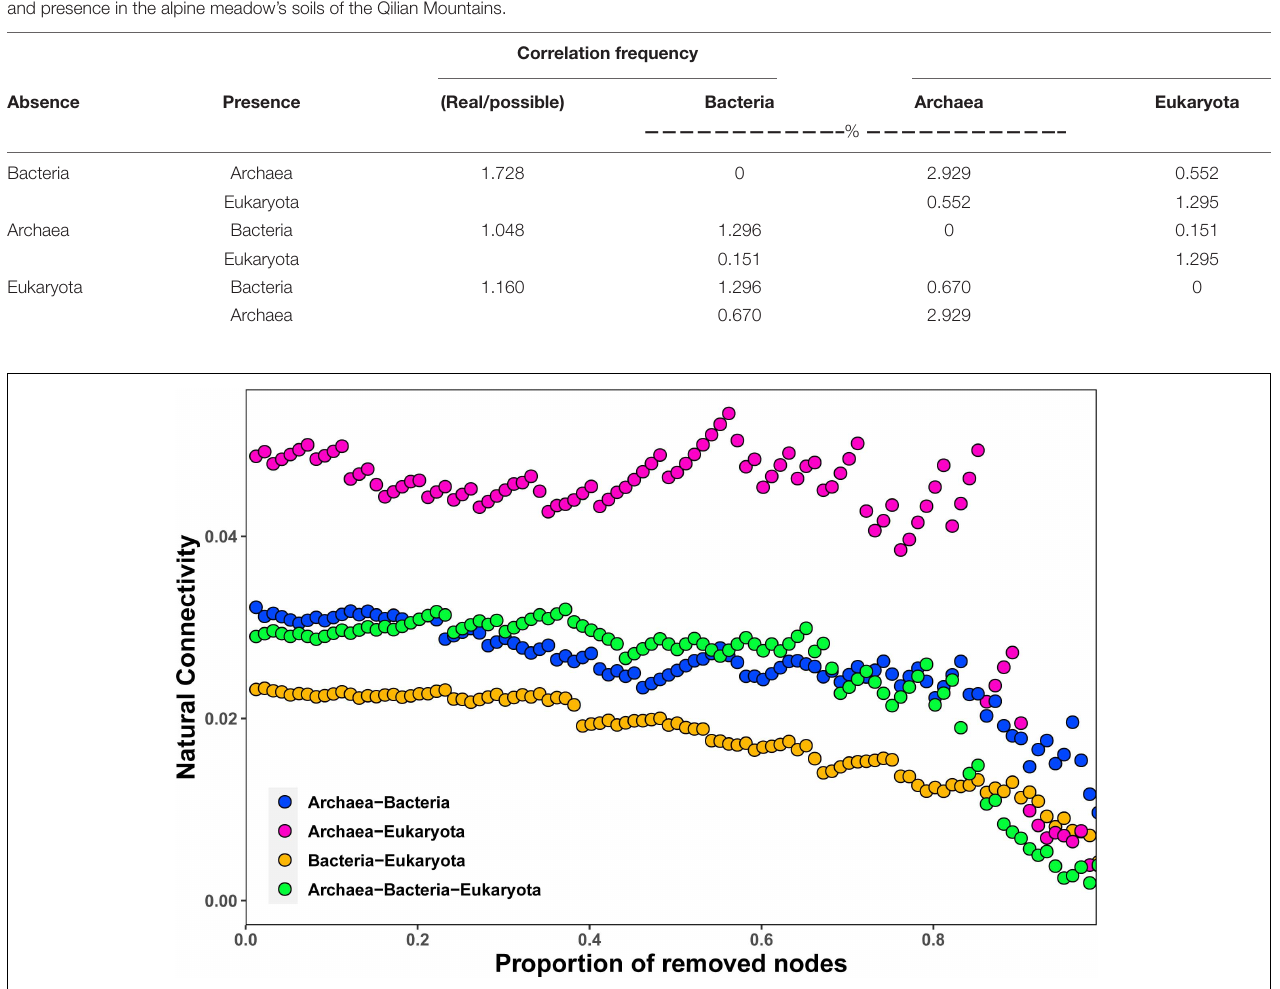
FIGURE 7 | Network robustness analysis of containing archaea–bacteria, archaea–eukaryota, bacteria–eukaryota, and archaea–bacteria–eukaryota microbial groups in the alpine meadow’s soils of the Qilian